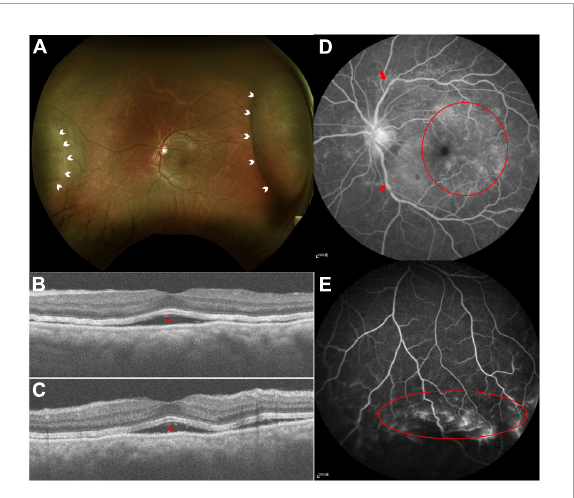
FIGURE4 (A) Color fundus photography demonstrated serous retinal detachment at the nasal and temporal arcade (white arrowheads). (B,C) Optical computed topography revealed subretinal fluid (red stars). (D) FA demonstrated tortuous retinal veins over branch retinal vessels (red arrows) and diffused macular dye leakage (red circle). (E) Peripheral retinal ischemic syndrome was observed by FA (red circle) with non-perfused peripheral retina.